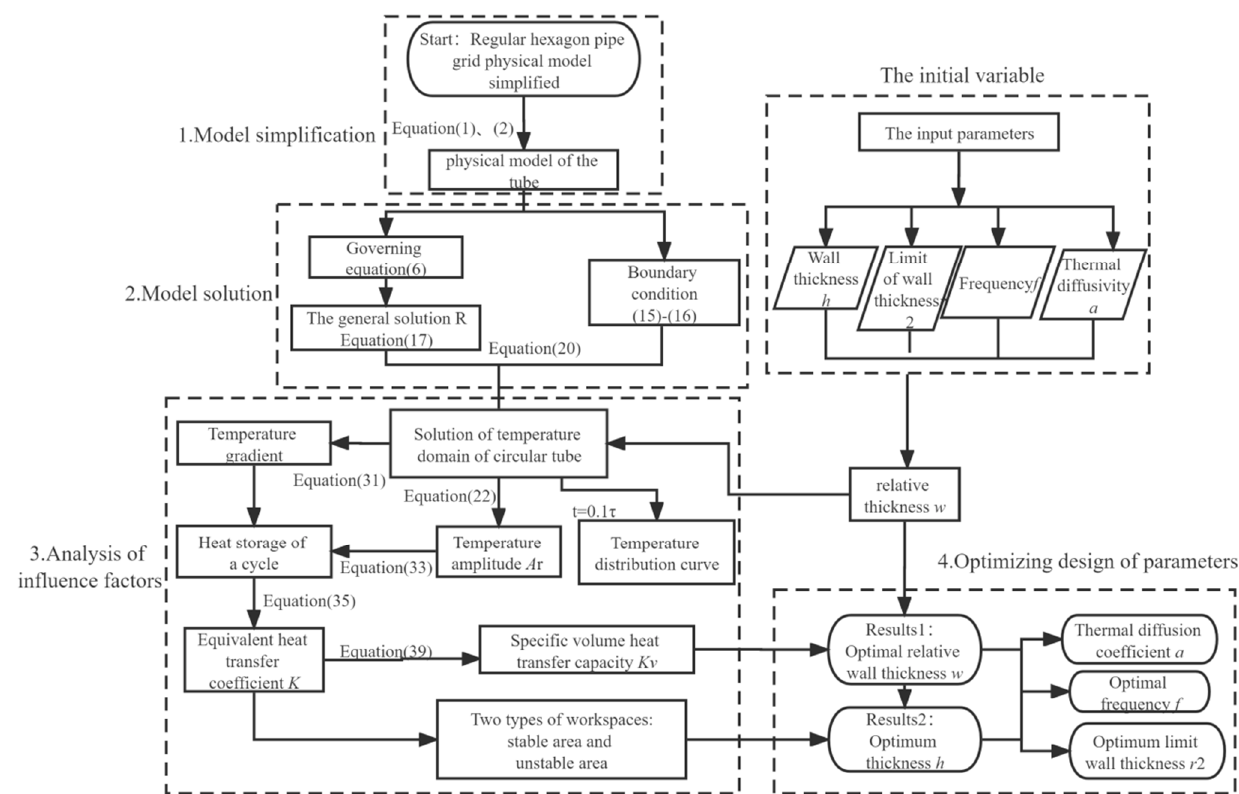
Figure 4. Logical flow chart.